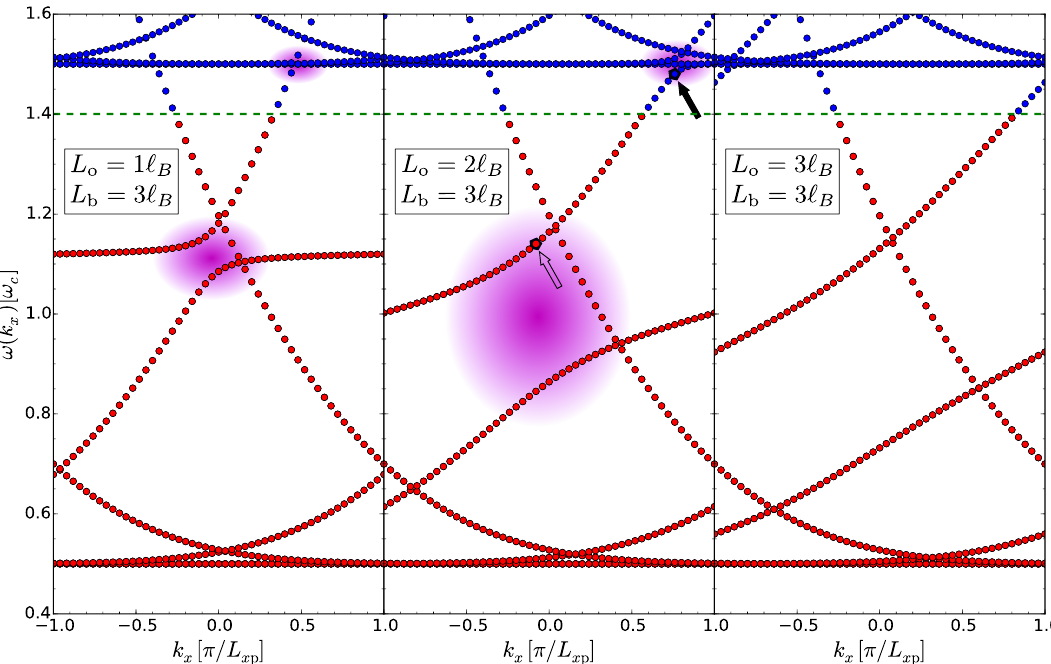
= 10 µ m, Figure 9: Energy spectra of the lowest eigen states of a quantum Hall sample with L y = 4.01 µ m, and (cid:96) = 1 µ m. The left panel shows the case of weakly coupled bays because L x p B the opening L is small. The middle panel shows a moderate coupling while the right panel o a rather strongly coupled case because the opening L is increased step by step. Red symbols o correspond to occupied states while blue symbols depict unoccupied states; the dashed hori- zontal green line indicates the chosen Fermi level. The shaded areas highlight the locations of two avoid crossings due to the hybridization of local and dispersive